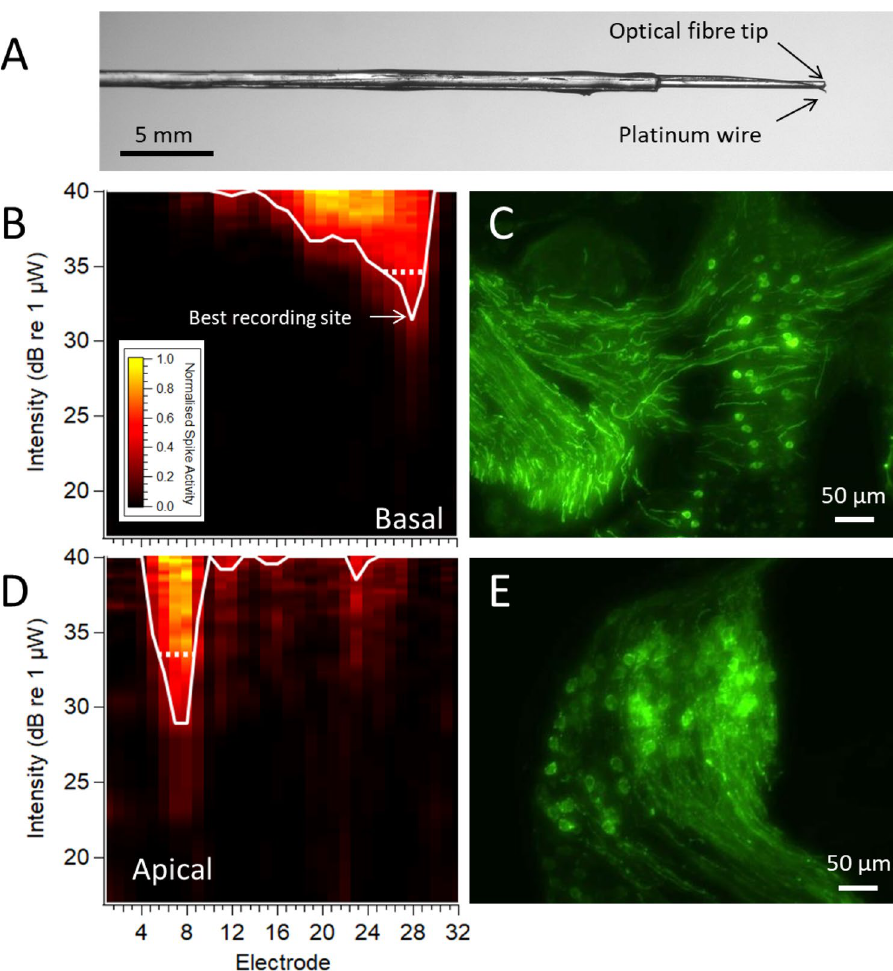
Figure 4. Cochleotopic multi-unit responses. ( A ) Optical fibre with bonded platinum wire. ( B ) Spatial response image to 1 ms optical pulses from a round-window positioned optical fibre in a neonatally AAV-injected C57BL/6 mouse. Low threshold multi-unit activity was recorded at ventral recording sites of the recording array in the inferior colliculus. Expression of ChR2-H134R-EYFP was observed in approximately 15–44% of total SGNs in the basal-mid region of the cochlea in this example, with the basal turn shown in ( C ). ( D ) Responses to apical optical stimuli were recorded in the more dorsal electrodes of the recording array in the inferior colliculus. Approximately 69% of total apical SGNs displayed ChR2-H134R-EYFP expression in this example ( E ). Each response image shows the spatial extent and normalised rate of multi-unit activity across the recording array which corresponds to depth in the inferior colliculus. Intensities were smoothed and normalized between spontaneous (black) and maximum rate (yellow). The white line represents the spatial tuning curve with threshold set to 30% of maximum activity. The dotted lines compare the width of activation at an equivalent level above threshold (d’ = 1 above threshold). Colour map in A applies to both response images. Minor image processing (brightness, contrast) was applied to images for representation